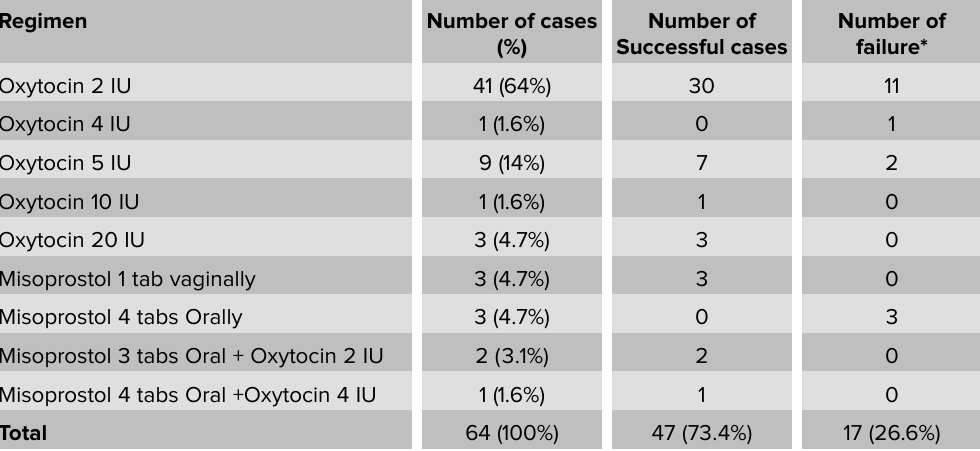
TABLE 3: Different regimen(s) used to induce labor among participants ( n = 64) Regimen Number of cases